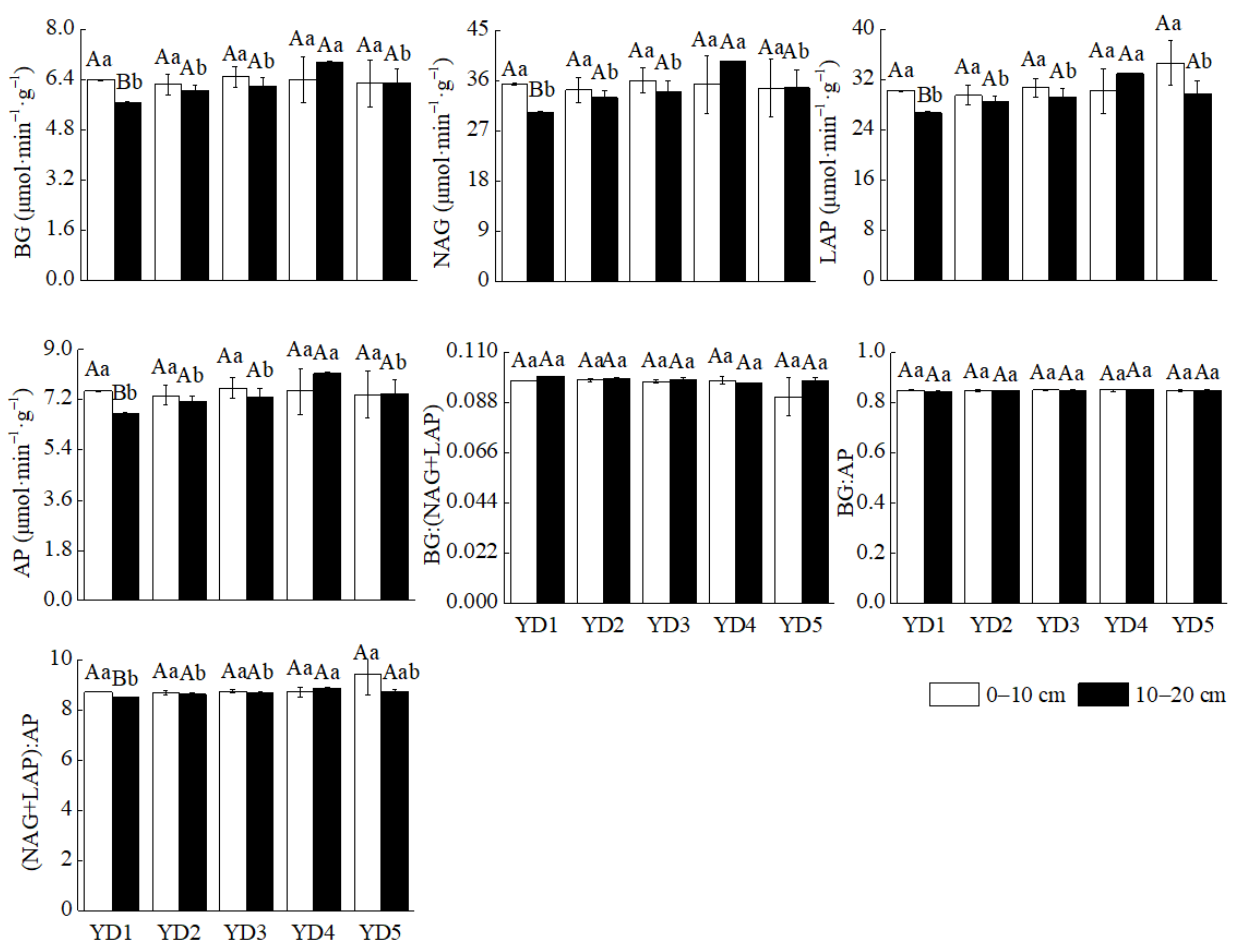
Figure 5. Soil extracellular enzymes activities (EEAs) and their stoichiometry of Z. planispinum plantations. BG, β -1,4-glucosidase; NAG, β -1,4-n-acetylglucosaminidase; LAP, leucine aminopeptidase; AP, acid phosphatase; BG:(NAG + LAP), ratio of β -1,4-glucosidase to the sum of β -1,4-n-acetylglucosaminidase and leucine aminopeptidase; BG:AP, β -1,4-glucosidase to acid phosphatase ratio; (NAG + LAP):AP, ratio of the sum of β -1,4-n-acetylglucosaminidase and leucine aminopeptidase to acid phosphatase. Lower case letters, significant differences between different plantation types of the same depth at p < 0.05; upper case letters, significant differences between different depths of the same plantation types at p < 0.05.